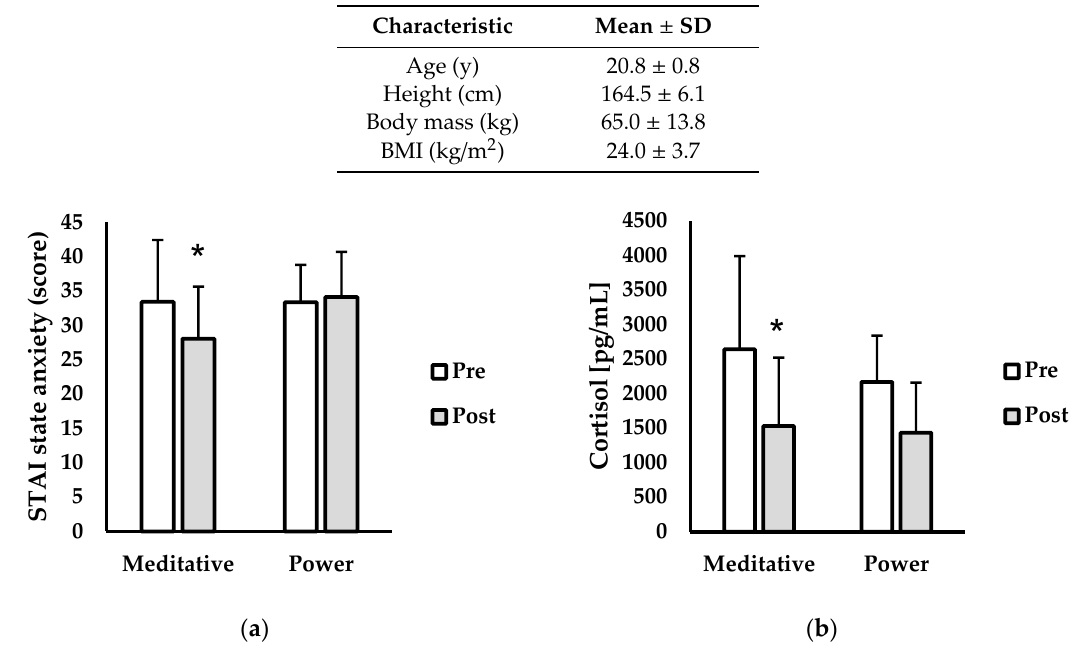
Figure 1. Psychological and physiological stress indices before (pre—white bars) and after (post—grey bars) either meditative or power yoga. ( a ) State–Trait Anxiety Inventory scores (STAI) (n = 13), ( b ) salivary cortisol levels (pg / mL; n = 11). Data are presented as mean ± SD. * Indicated significantly different from pre-meditative ( p < 0.05).